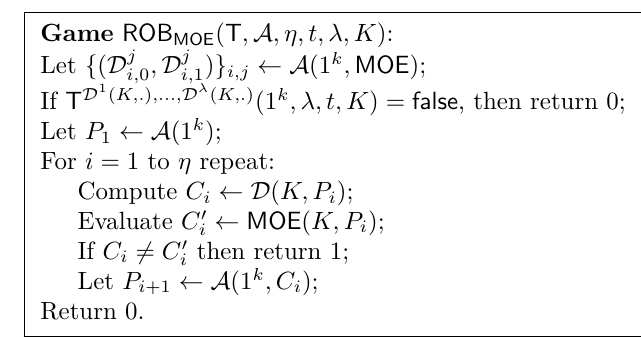
Figure 2: The formal robustness game ROB MOE